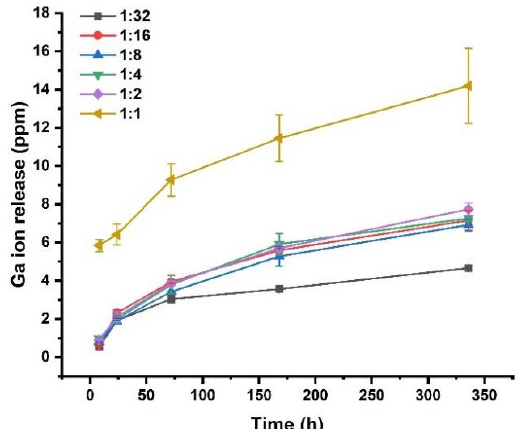
Figure 4. Cumulative ion release profile of gallium from different Ga (III)-CS complexes in PBS.